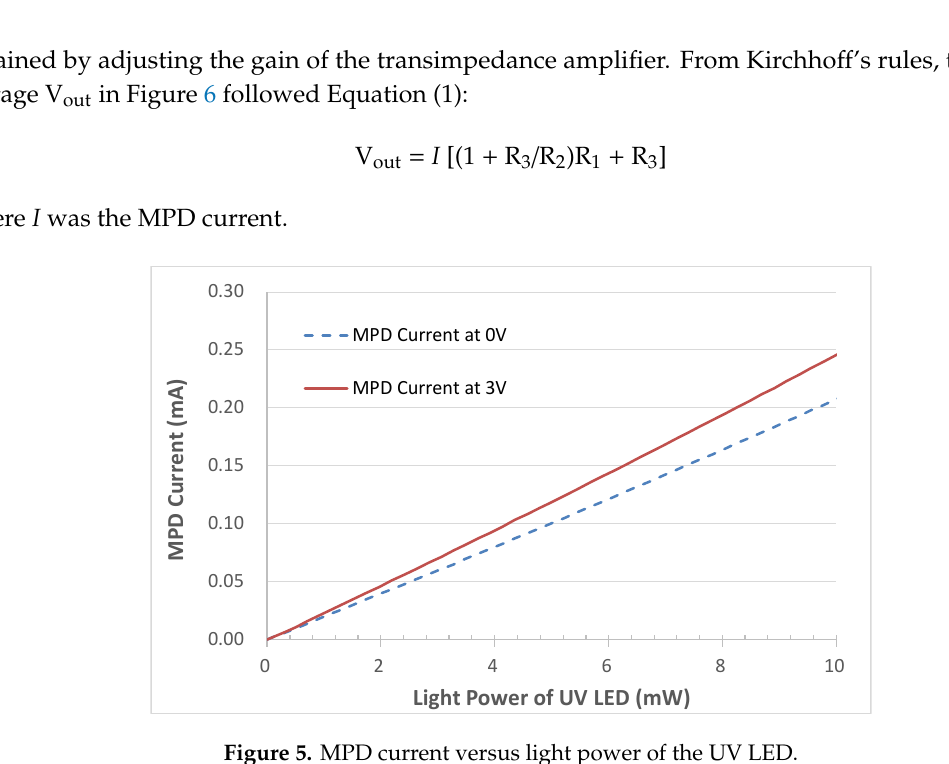
Figure 5. MPD current versus light power of the UV LED.